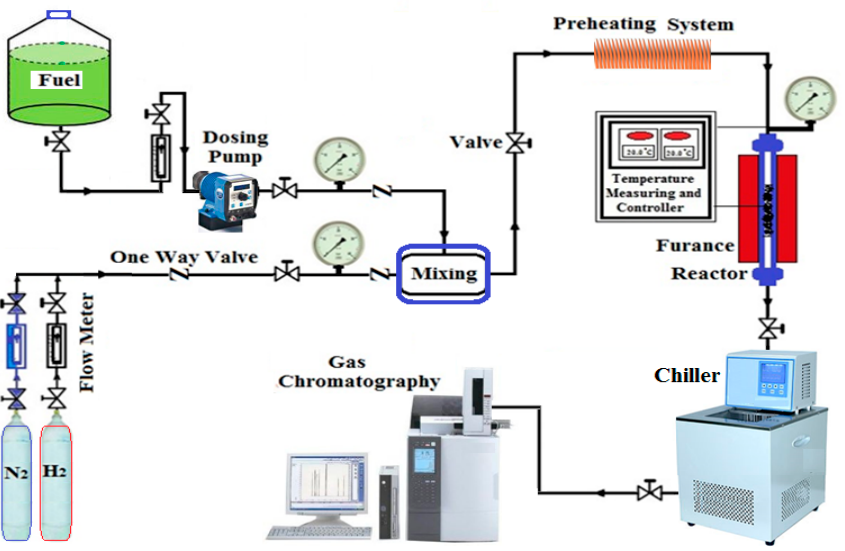
Figure 2. Schematic representation of the catalytic reforming rig. Table 1. Calculated experimental work uncertainties of catalytic reforming parameters.